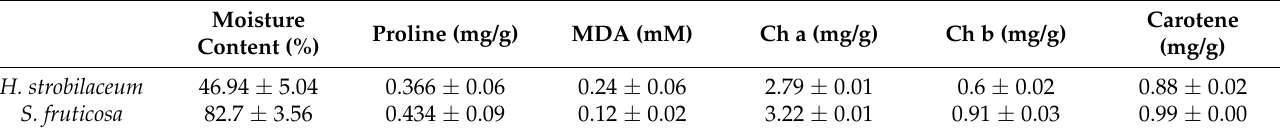
Table 1. Physiological statements of the aerial part of H. strobilaceum and S. fruticosa . Moisture